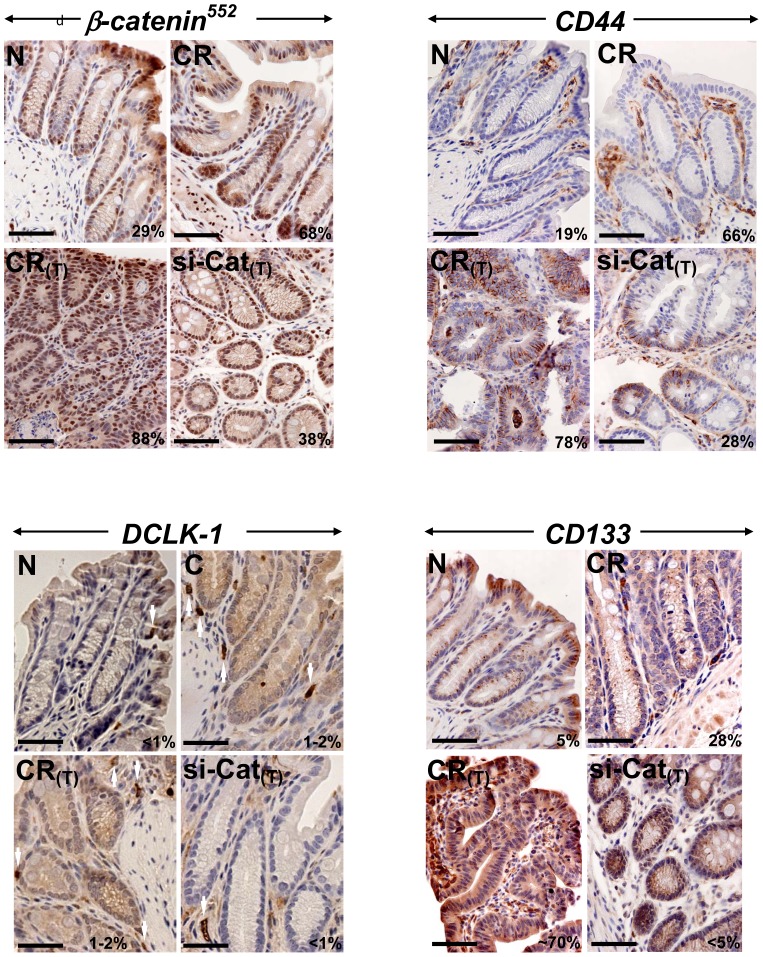
Effect of β-catenin knockdown on tumorigenesis in Apc
Min/+ mice.Representative photomicrographs of paraffin embedded sections prepared from the distal colons of uninfected normal (N), CR-infected at day 12, CR-infected mice at 3 months of age with tumor (CRT) and CRT mice treated with nanoparticle-encapsulated β-catenin siRNA (si-Cat(T)). Sections were stained with antibodies for: β-catenin phosphorylated at Ser-552 (β-catenin552) and cancer stem cell markers CD44, Dclk1 and CD133, respectively. Percentages represent percent cells positive for indicated markers. Scale bar: 50 µm; n = 2 independent experiments.